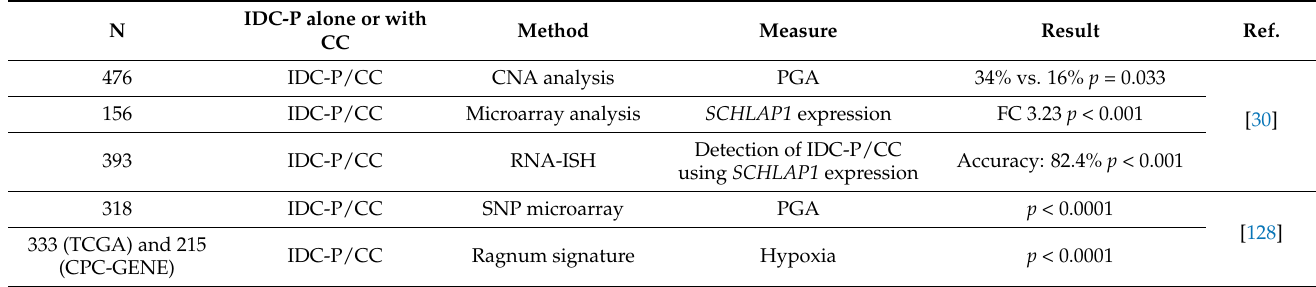
Table 5. Overview of the studies evaluating the impact of the molecular characteristics of IDC-P alone or in combination on prostate cancer outcome in radical